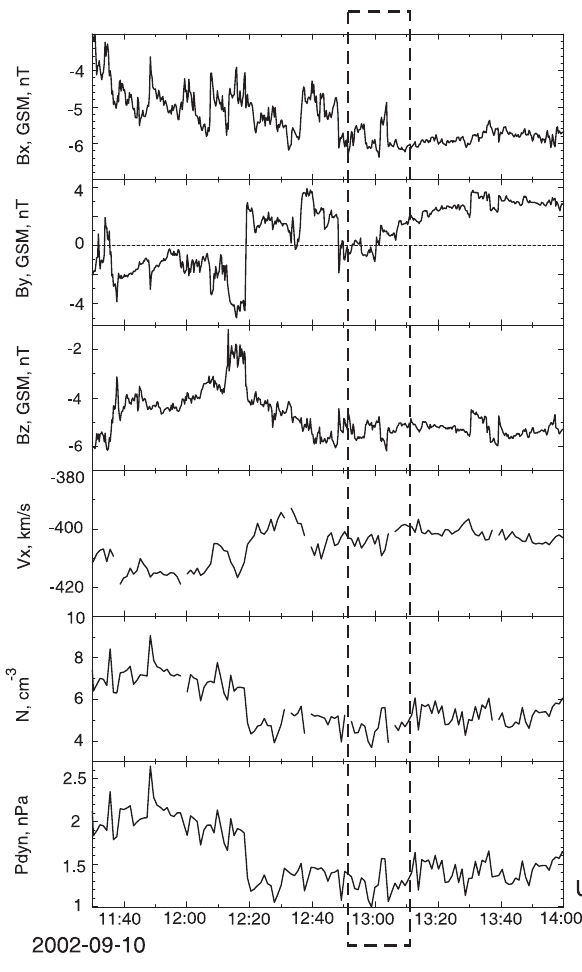
Fig. 2. Solar wind conditions for 10 September 2002. The top three panels show three components of the interplanetary magnetic field (IMF) in the geocentric solar magnetospheric (GSM) coordi- nate system. The bottom three panels show the X-component of the solar wind velocity (GSM), density and dynamic pressure of the so- lar wind. The dashed box marked the time of interest, when Cluster was in the northern LLBL/cusp. The appropriate time lag is